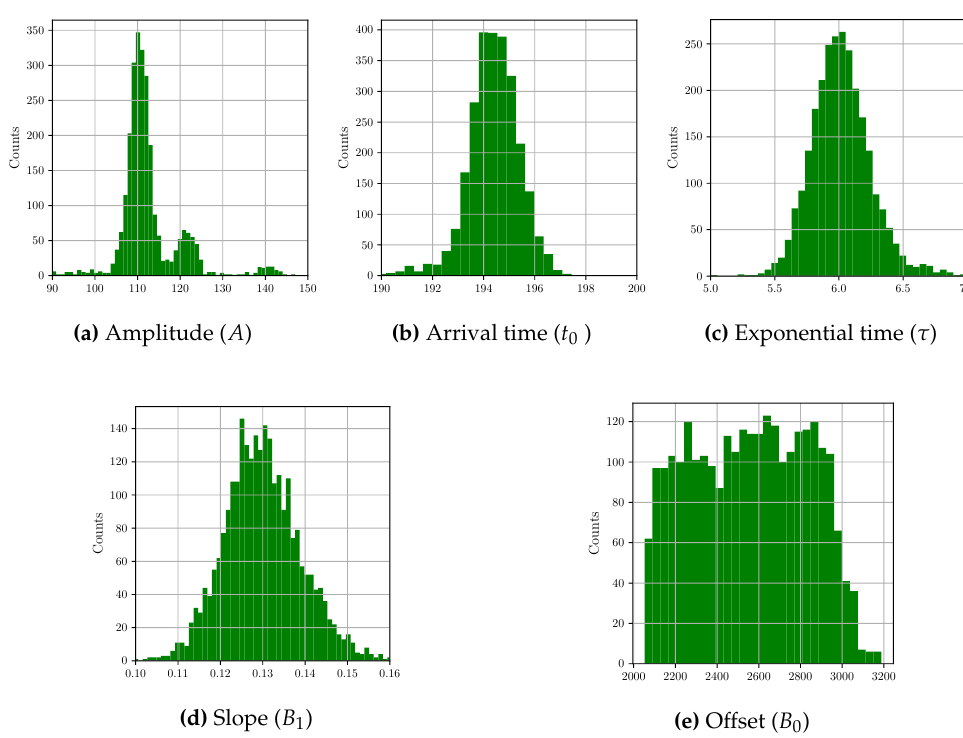
Figure 9. Histograms of the fitted parameters corresponding to the bi-exponential model. Table 2. Mean values and standard deviations of the fitted model